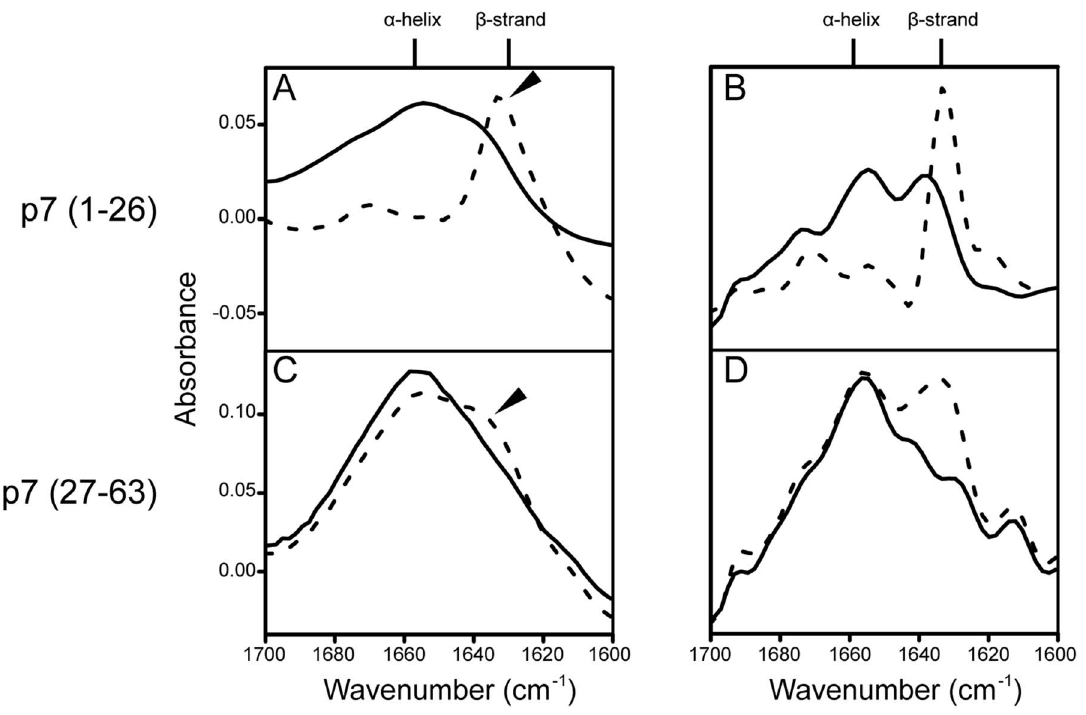
Figure 6. Secondary structure of N- and C-terminal fragments of p7. Infrared amide I region of (A) fragment p7(1-26), and its Fourier self deconvolved spectrum (B); C and D, same for fragment p7(27-63). Samples pre-solubilized and dried from methanol and HFIP are indicated as dotted and solid lines, respectively.